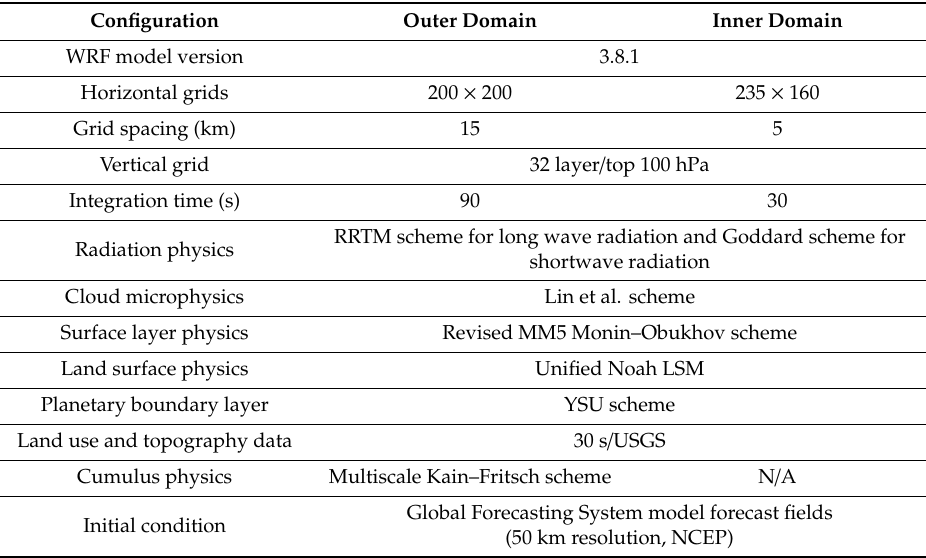
Table 1. Default model configuration and physical parameterization.